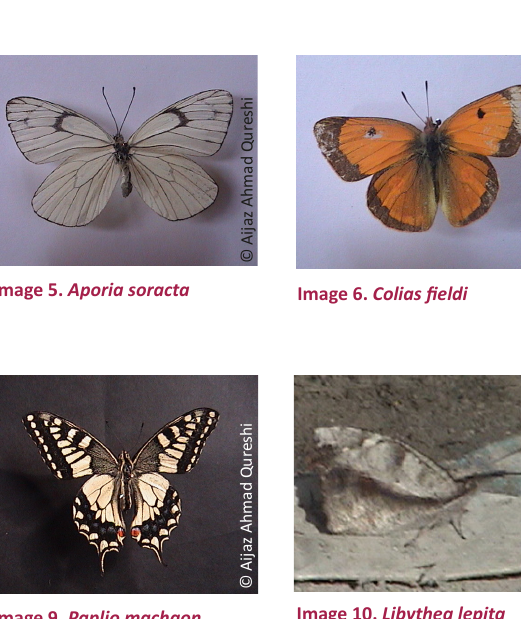
Image 13. Neptis sappho (upperside)